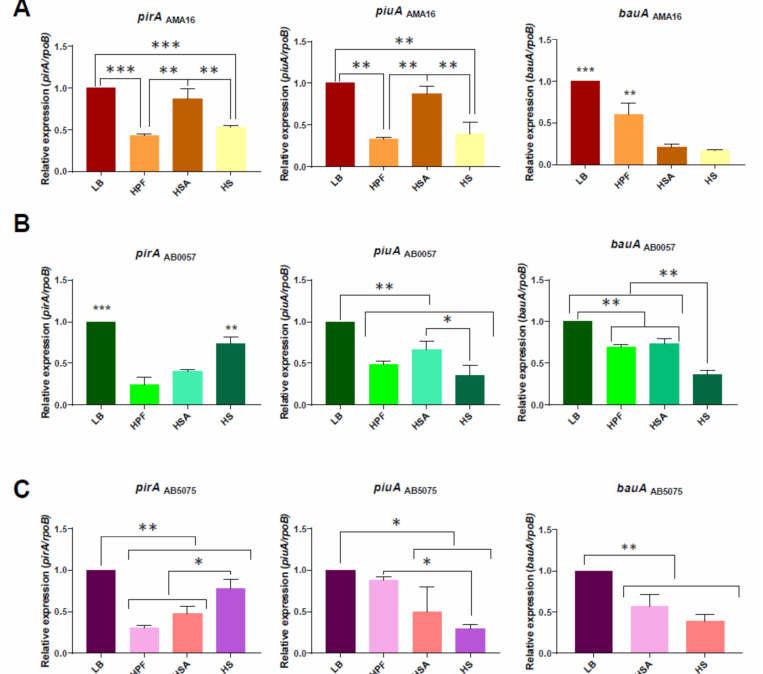
Figure 1. Genetic analysis of iron uptake genes of AMA16 ( A ), AB0057 ( B ), and AB5075 ( C ) A. baumannii strains and qRT-PCR of genes associated with iron uptake, pirA , piuA , and bauA, ex- pressed in LB, LB supplemented with HPF or with HSA, or cultured in HS. Fold changes were calculated using double ∆ Ct analysis. At least three independent samples were used, and four technical replicates were performed from each sample. The LB was used as reference. Statistical significance ( p < 0.05) was determined by ANOVA followed by Tukey’s multiple comparison